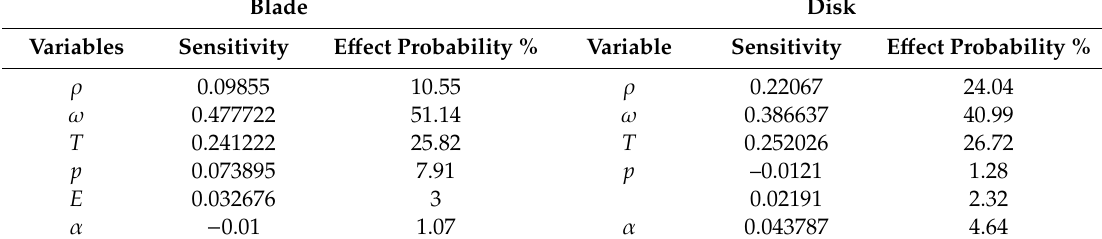
Table 3. Sensitivity index of a bladed disk.